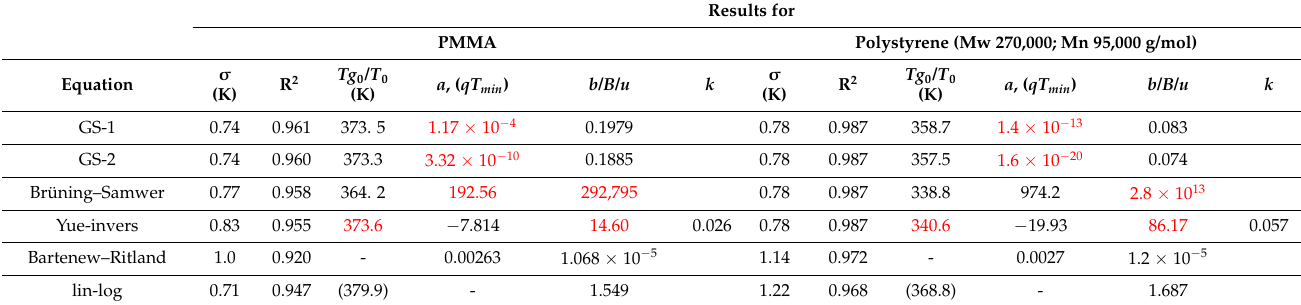
Table 7. Regression results for the high polymers PMMA and PS.